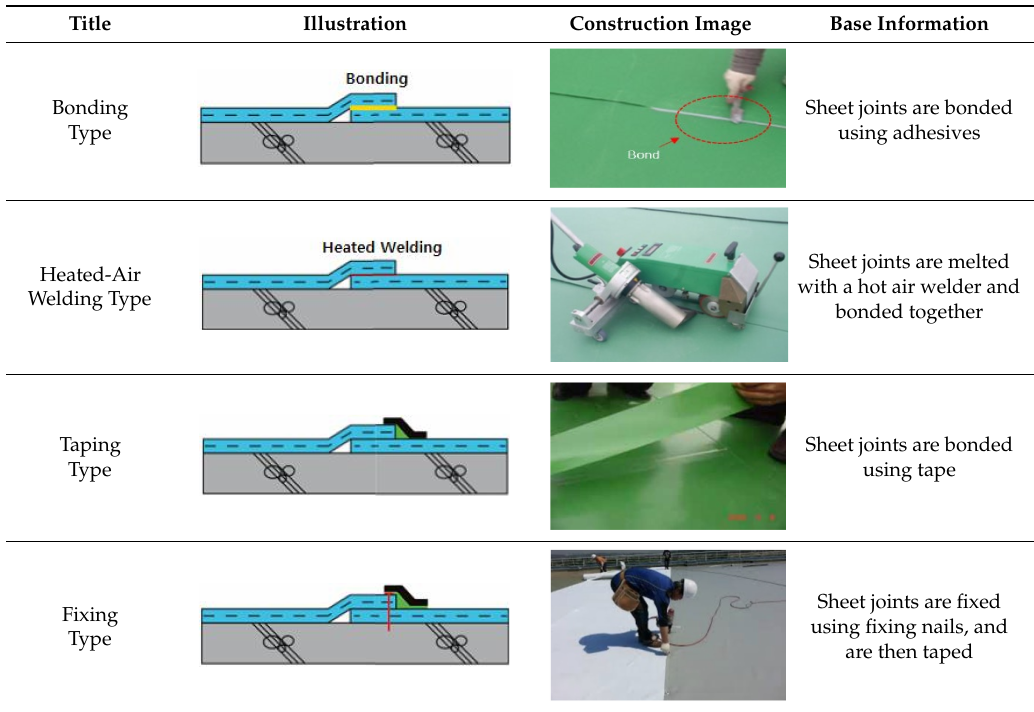
Table 1. Common ethylene vinyl acetate (EVA) overlap joint types.